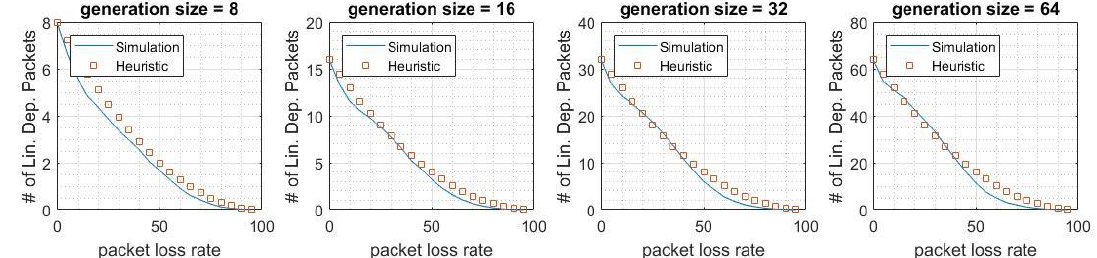
Figure 7. Number of linearly dependent packets in D in cache